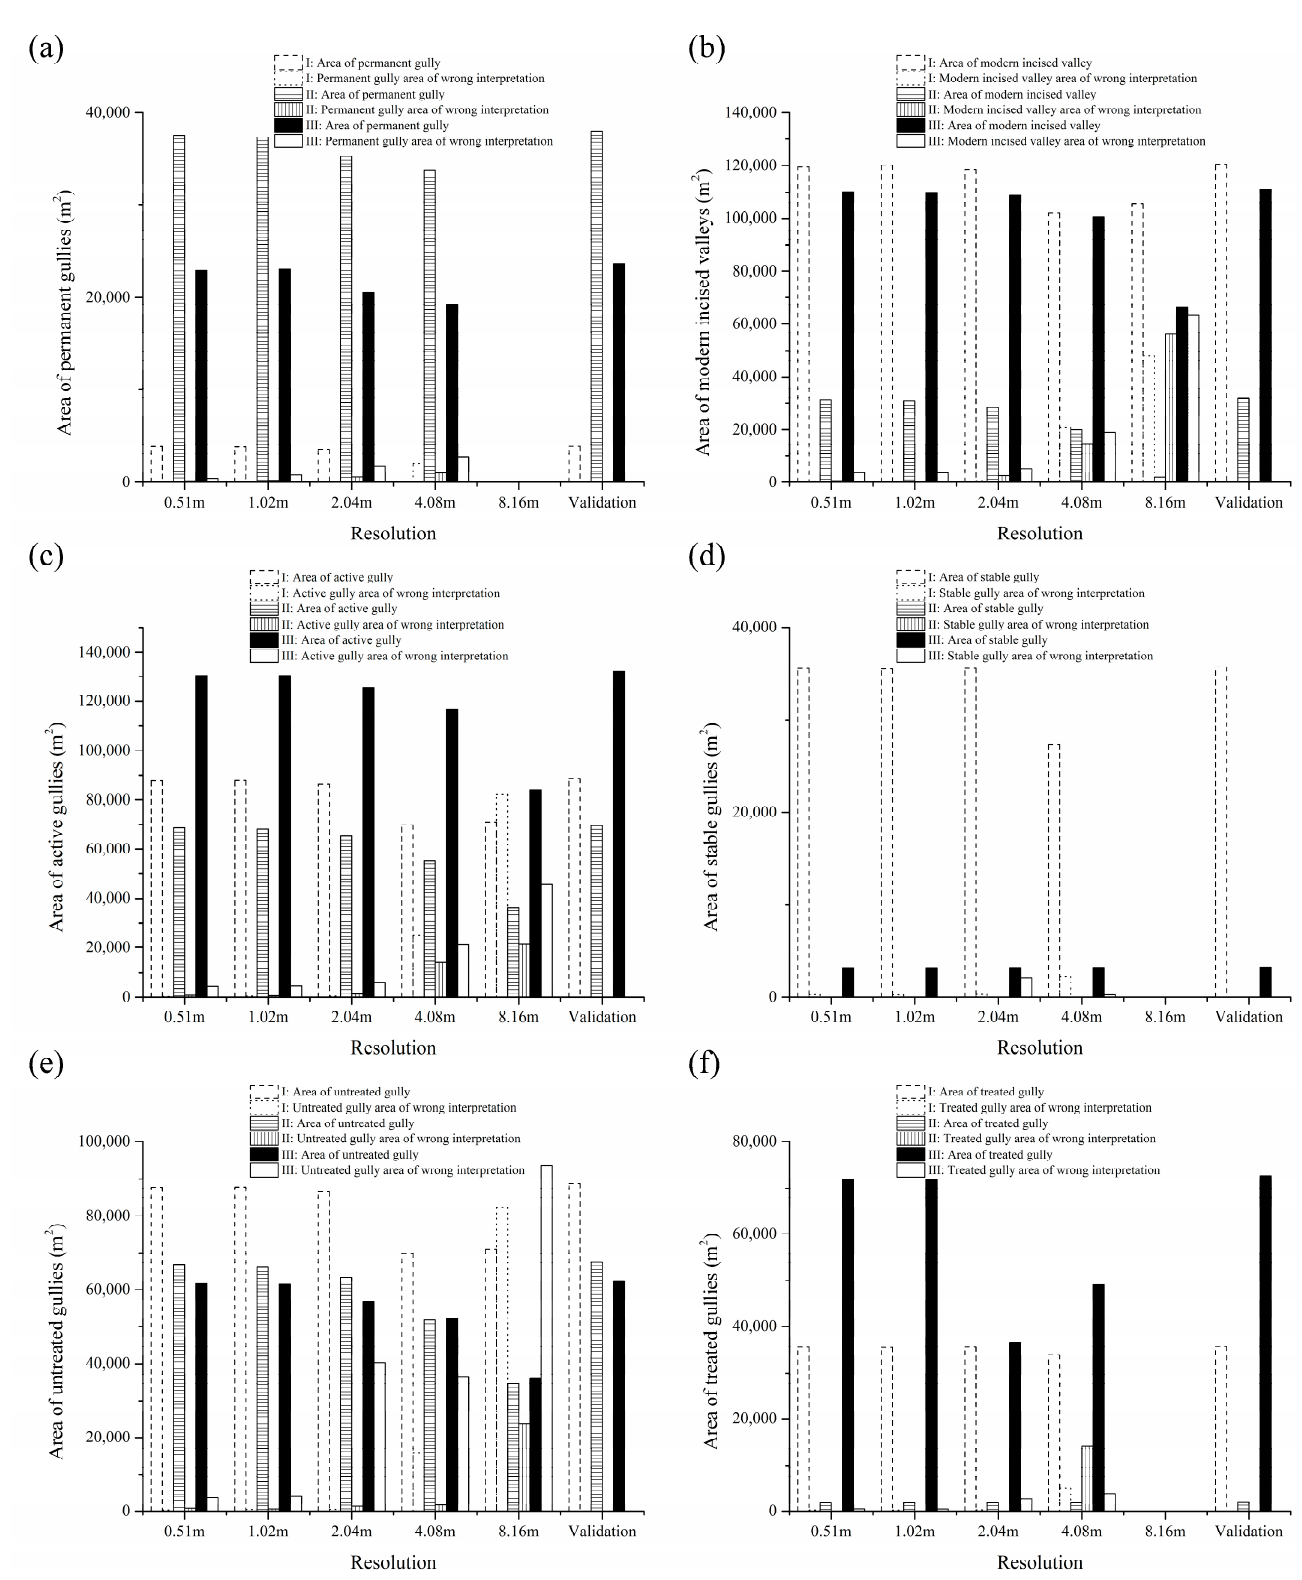
Figure 5. Area of gullies. ( a , b ) Area of permanent gullies and modern incised valleys. ( c , d ) Area of active gullies and stable gullies. ( e , f ) Area of untreated gullies and treated gullies.